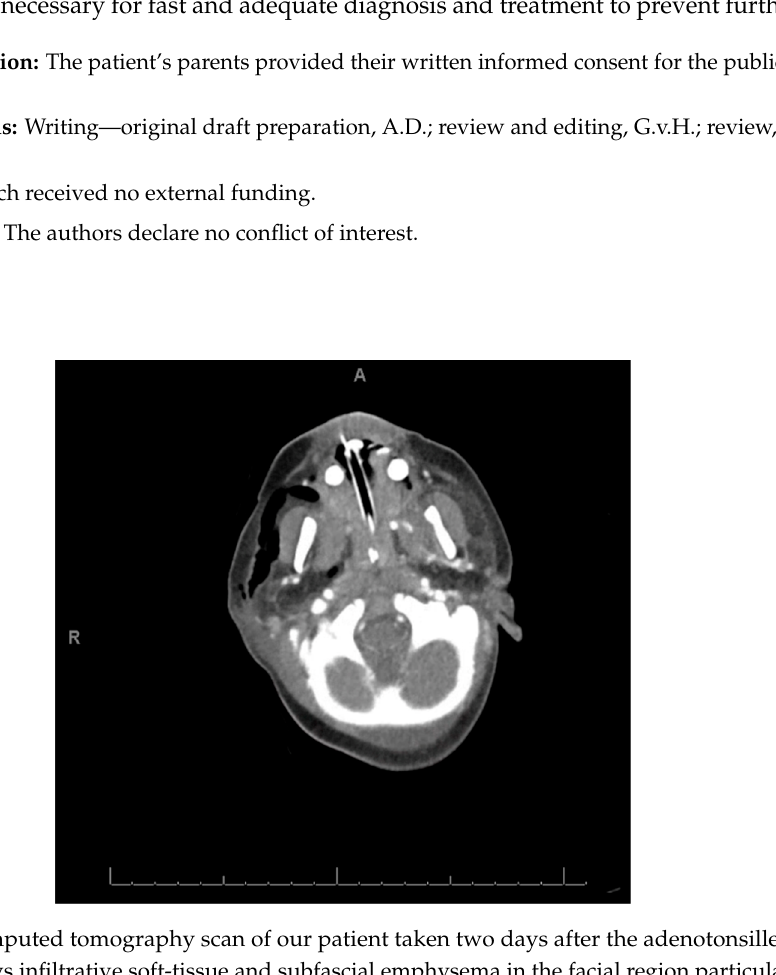
Figure A1. Computed tomography scan of our patient taken two days after the adenotonsillectomy. The image shows infiltrative soft-tissue and subfascial emphysema in the facial region particularly on the right